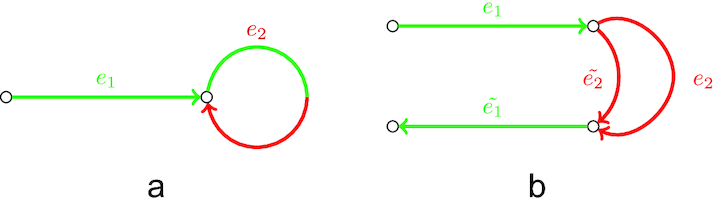
Examples of chimeric connections in the de Bruijn graph typical for transcriptome assembly. Red and green indicate erroneous and correct sequences, respectively. (a) A chimeric loop (edge e2) connecting the end of the correct transcriptomic edge e1 with itself. (b) An example of a chimeric hairpin, where erroneous edge e2 connects a correct edge e1 with its reverse-complement copy \documentclass[12pt]{minimal}
\usepackage{amsmath}
\usepackage{wasysym}
\usepackage{amsfonts}
\usepackage{amssymb}
\usepackage{amsbsy}
\usepackage{upgreek}
\usepackage{mathrsfs}
\setlength{\oddsidemargin}{-69pt}
\begin{document}
}{}$\tilde{e_1}$\end{document}. Because e2 connects a vertex and its reverse-complement, \documentclass[12pt]{minimal}
\usepackage{amsmath}
\usepackage{wasysym}
\usepackage{amsfonts}
\usepackage{amssymb}
\usepackage{amsbsy}
\usepackage{upgreek}
\usepackage{mathrsfs}
\setlength{\oddsidemargin}{-69pt}
\begin{document}
}{}$\tilde{e_2}$\end{document} (the reverse-complement of e2) also connects these 2 vertices.